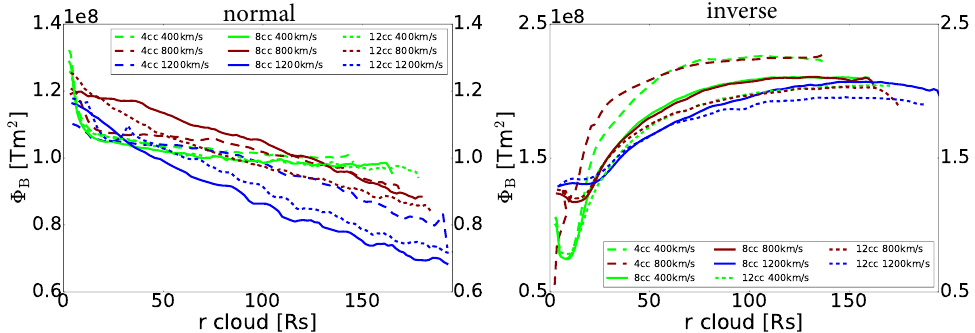
Figure 11. Magnetic flux evolution of magnetic cloud for a normal CME ( left ) and an inverse CME ( right ). The x -axis represents the location of the centre of the magnetic